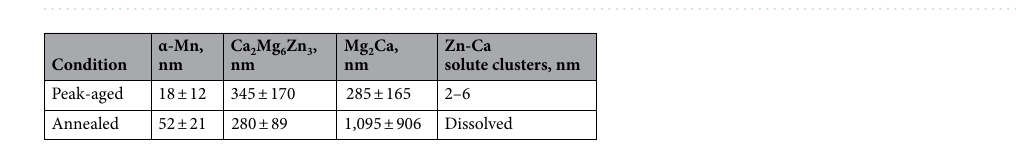
Figure 6. ( a ) TEM image showing the alpha-Mn precipitates in the annealed material, ( b ) SEM image showing the Mg 2 Ca (point 3) precipitates, confirmed by the ( c ) EDS scan, along with other two precipitates; ( d ) shows stacking faults (arrows) in the annealed material; ( e – h ) show the APT reconstruction of the Mn-Zn-Ca nanoclusters for the ( e – f ) peak-aged material, and ( g , h ) their dissolved state for the annealed material.